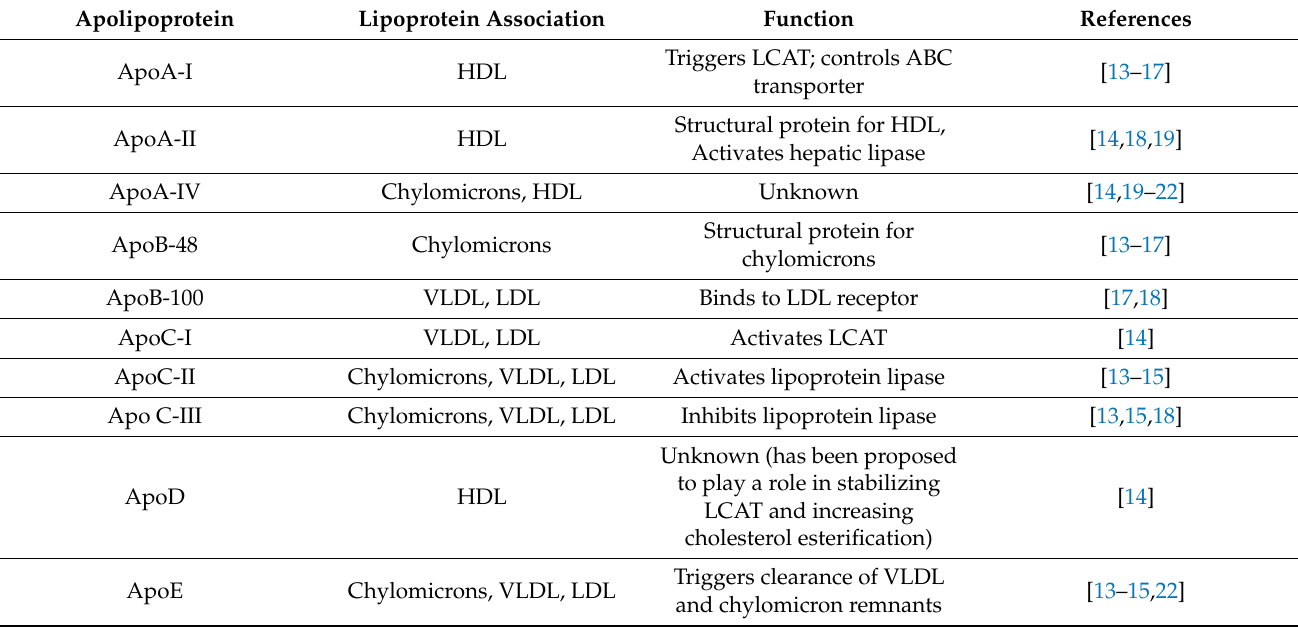
Table 1. Enzymes involved in plasma lipoprotein